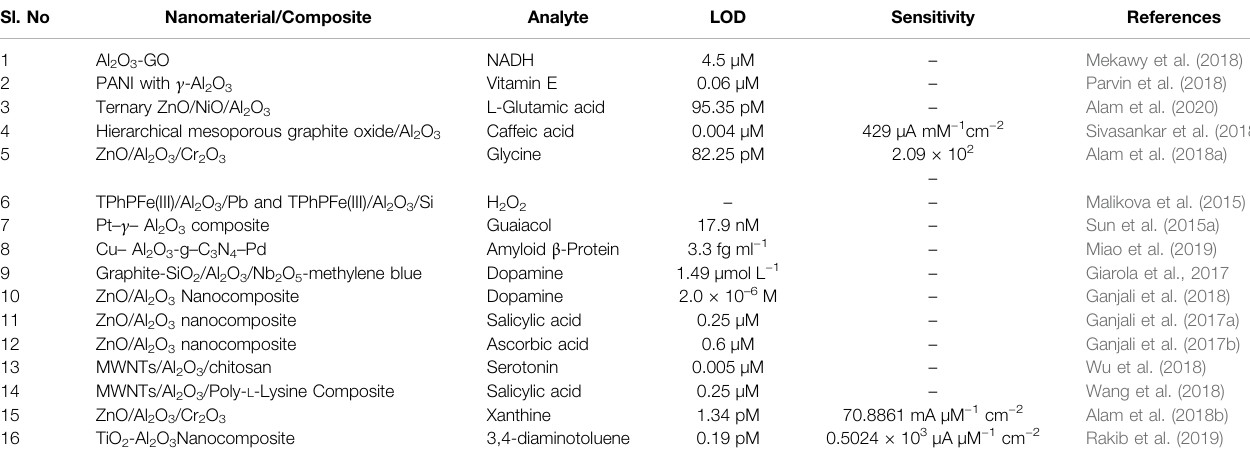
TABLE 2 | Al 2 O 3 nanoparticles as ceramic sensors for detection of biomolecules. Sl.